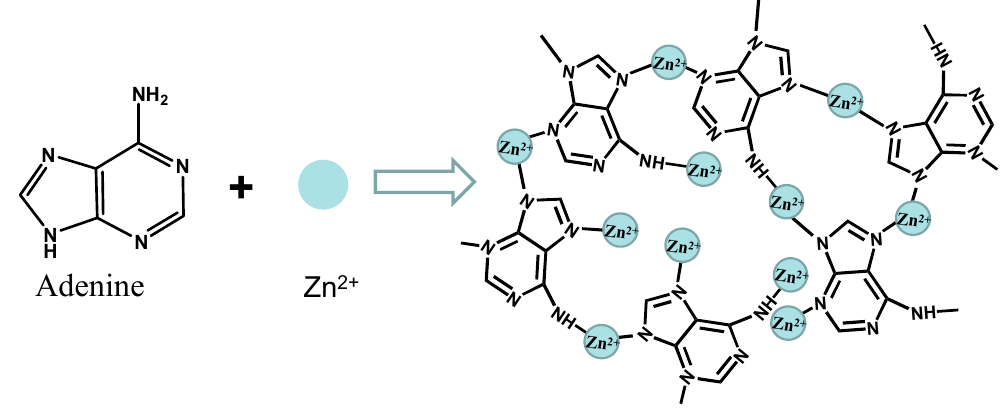
Figure 2. A scheme of Zn 2+ reacting with adenine, forming CPs.